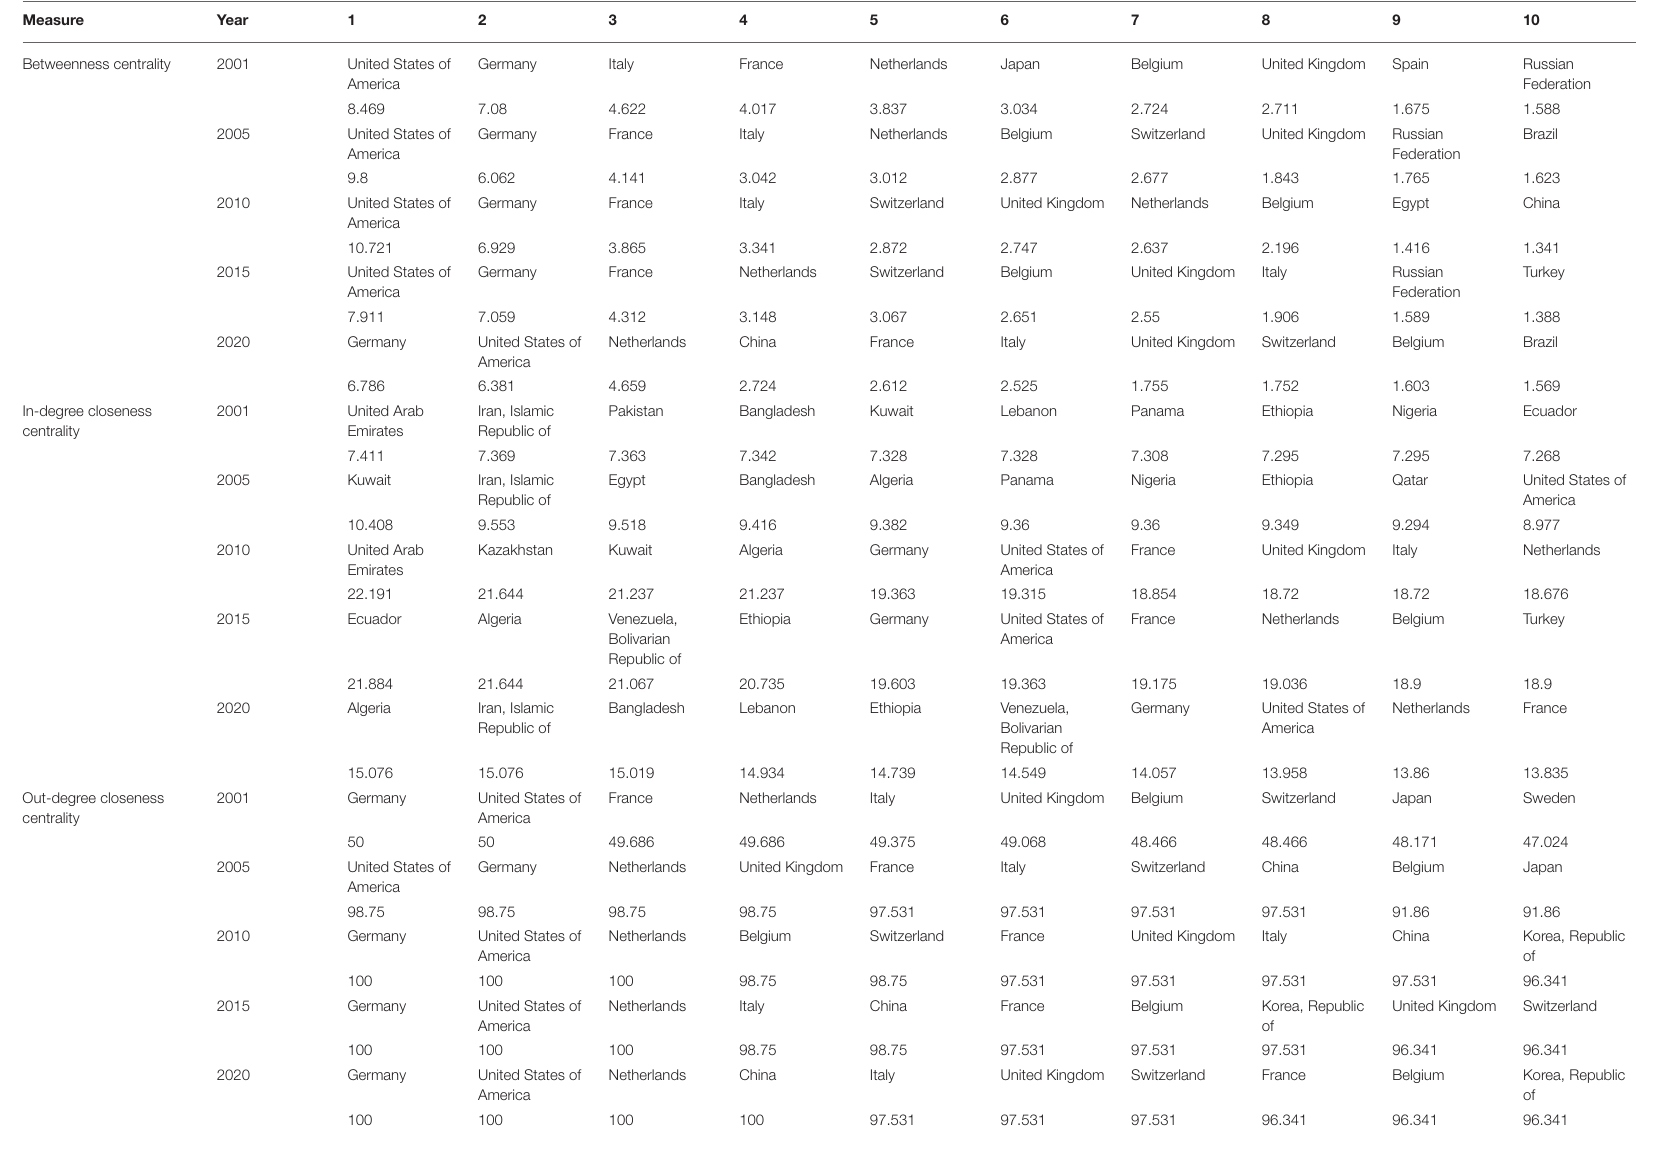
TABLE 3 | Changes in the top 10 ranking of economies based on centrality in the global medical device trade network.